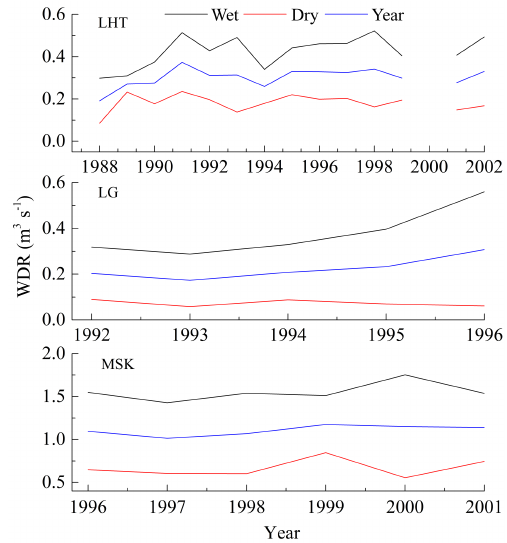
Figure 5. Variation in flow among sites in the wet season, dry sea- son, and whole year during the study